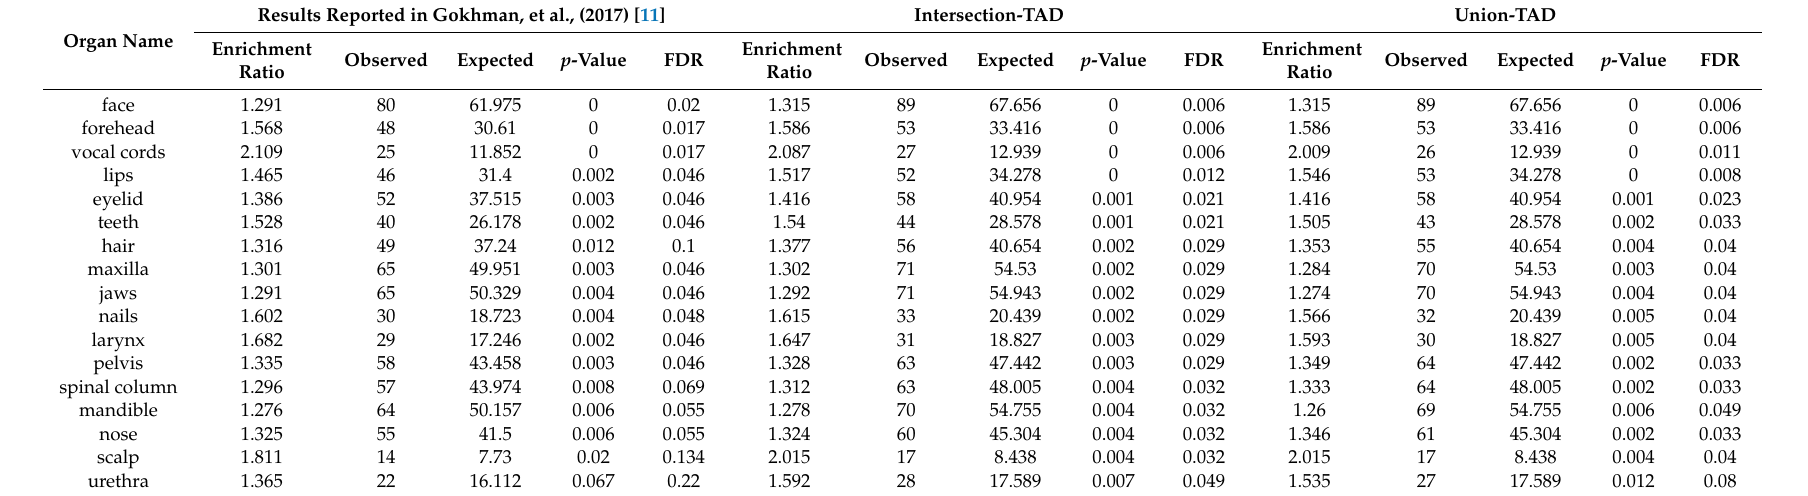
Table 1. Anatomical parts significantly enriched in any of the analyses. Previous results that did not use topological information are compared to the results obtained here. FDR values in the current analyses decreased, and new anatomical parts became significant: spinal column, chin, hair, and